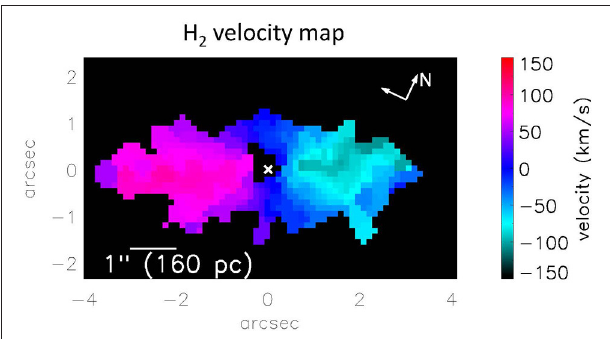
FIGURE 2 | Molecular gas velocity field determined from the H 2 2.12 µ m emission line. The cross indicates the position of the AGN. Reproduced with permission from Raimundo et al.